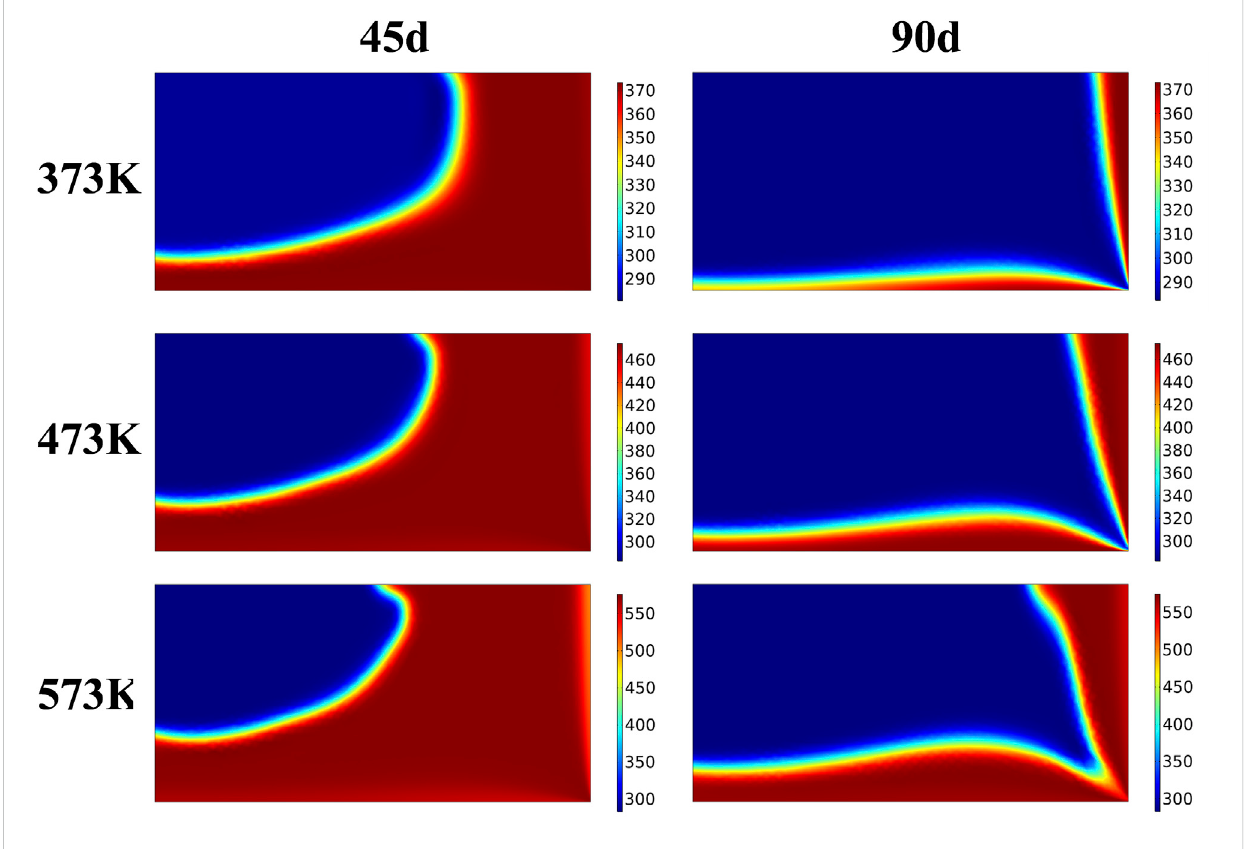
FIGURE 13 Temperature distribution of the system during heat production at different injection